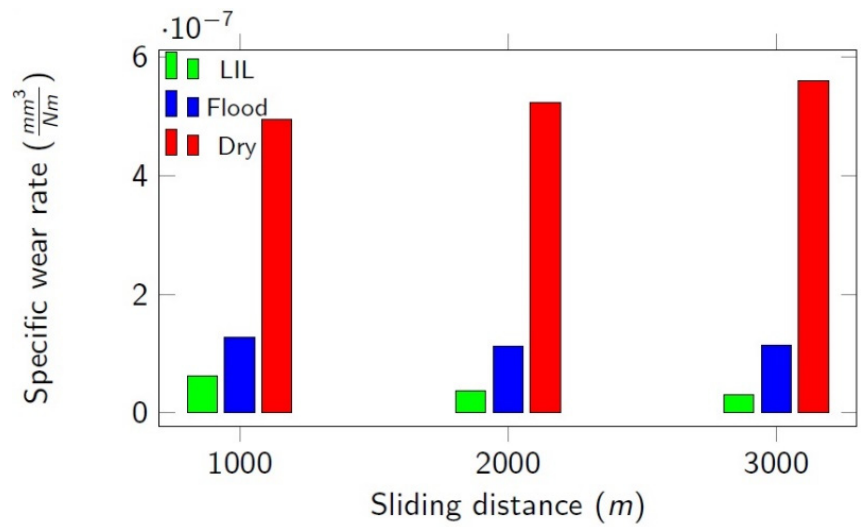
Figure 13. Specific wear rate, K [mm 3 /Nm].